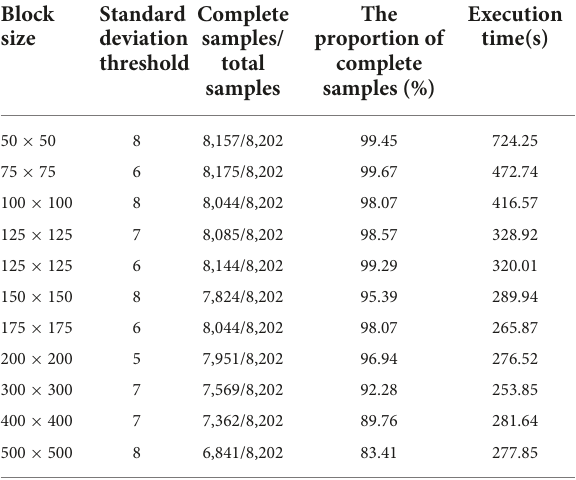
TABLE 3 Block threshold binarization performance evaluation table.